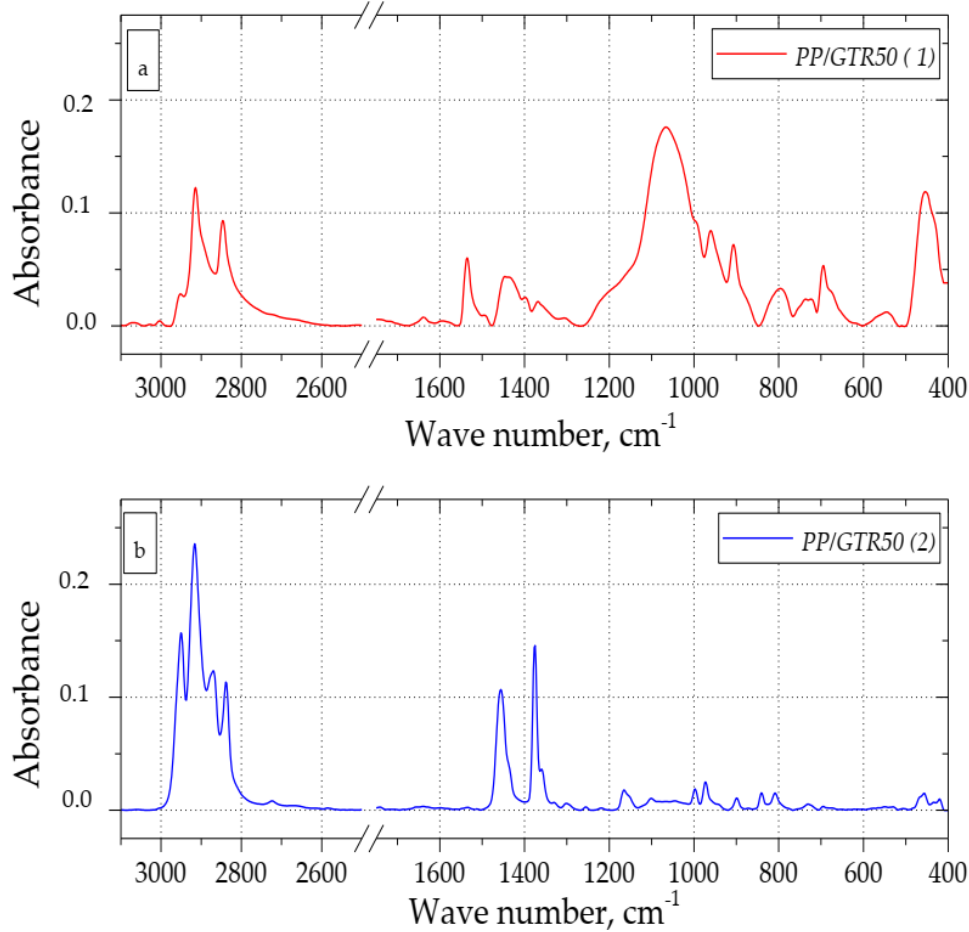
Figure 10. FT-IR spectra of PP/GTR50: sample 1 ( a ), sample 2 ( b ). Chosen FTIR spectra recorded during the tests of PP/GTR70 and PP/GTR70-P sam- ples are shown in Figure 11. The bands in the range from 1500 cm − 1 to 800 cm − 1 indicate